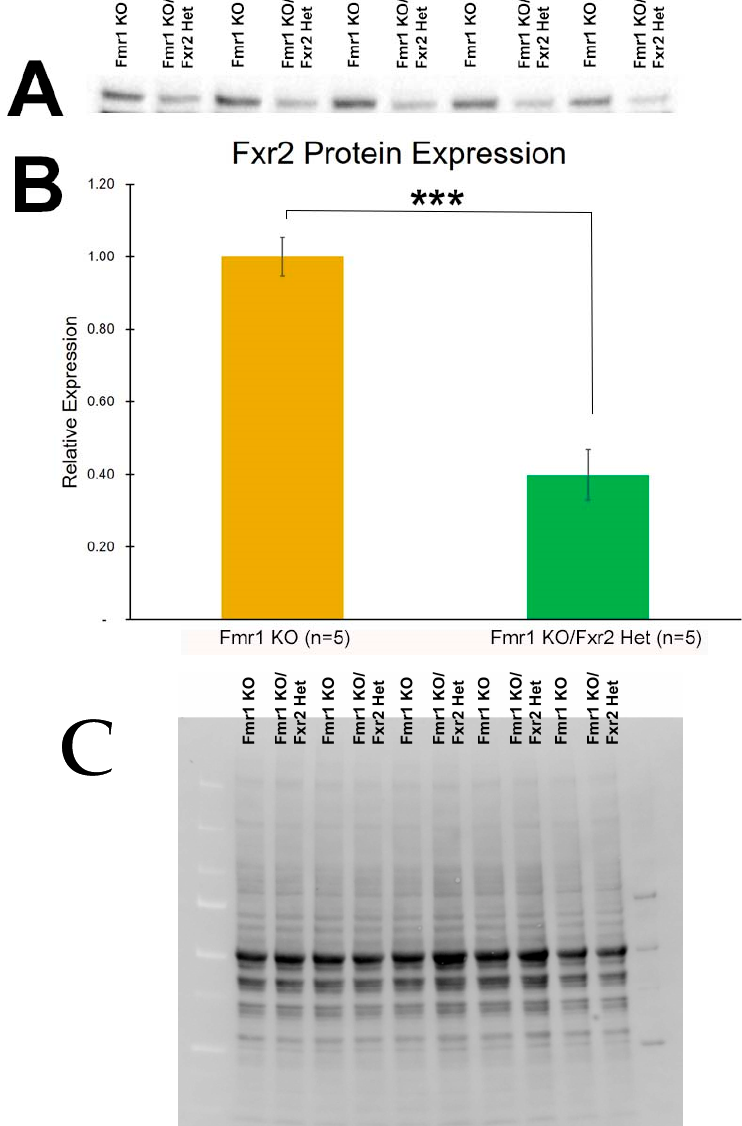
Figure 1. FXR2 protein expression is reduced in Fxr2 heterozygous mice. ( A ) Western blots showing FXR2 protein expression in Fmr1 KO and Fmr1 KO / Fxr2 Het hippocampus. ( B ) FXR2 protein expression is reduced by 60% in Fmr1 KO / Fxr2 Het animals (*** p = 0.0001, student’s t -test). Each bar represents the mean ± SEM for the number of mice indicated on the figure. (C) Stain-free image of